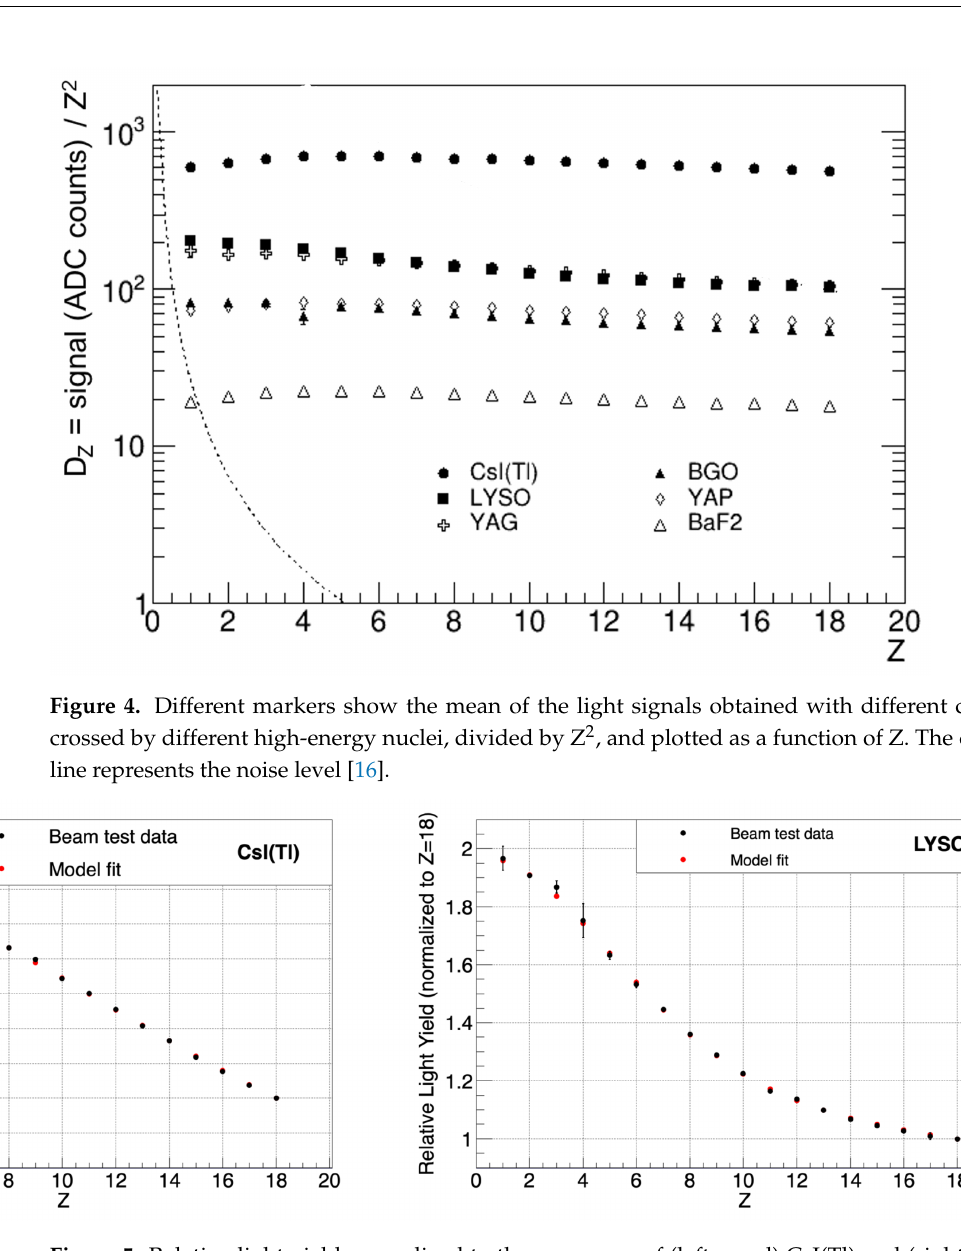
Figure 5. Relative light yield normalized to the argon one of (left panel) CsI(Tl) and (right panel) LYSO. Black points are the result of beam test data analysis, while red points are the result of the fit with the minimalist model; Equation (3) [16]. Table 3. Parameters of Equation (3) obtained with the fit of CaloCube data